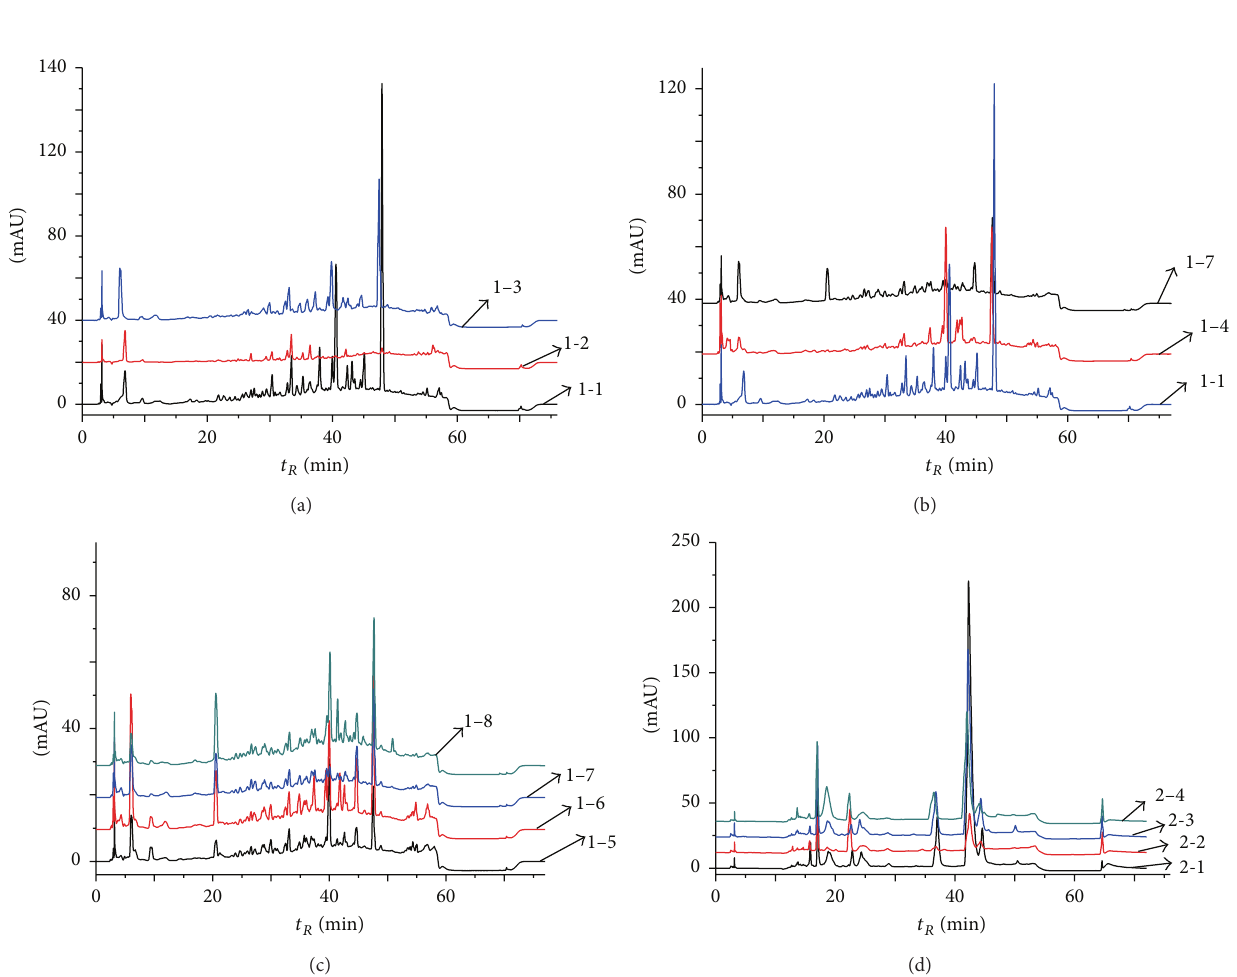
Figure 1: Comparison of fingerprints of different collection parts (a), collection time (b), and different origins (c) of Hibiscus mutabilis L. and different species of Berberidis radix (d) by